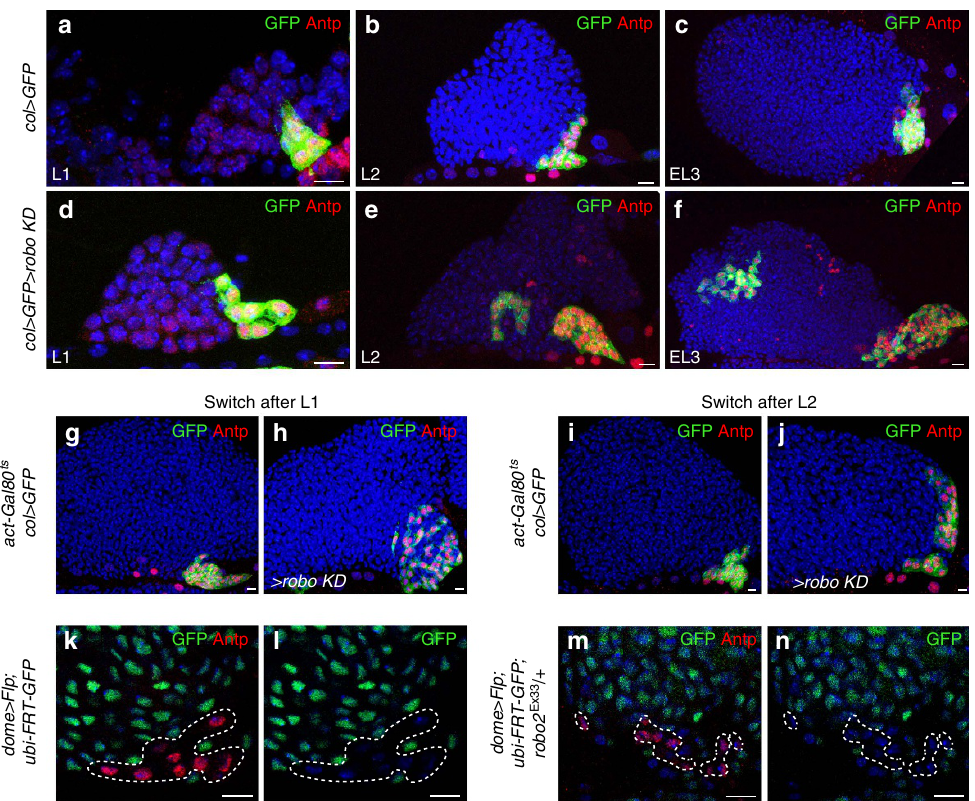
Figure 2 | Robo receptors are required to control PSC morphology during larval development and MZ lineage tracing. ( a – f ) Antp (red) and GFP (green) label PSC cells in control ( col 4 GFP ) ( a – c ) and in col 4 robo KD LGs ( d – f ). ( a , d ) L1 larvae, ( b , e ) L2 larvae and ( c , f ) early L3 larvae. ( g , j ) Antp (red) and GFP (green) label PSC cells in Gal80ts context; control ( col 4 ) ( g , i ) and in col 4 robo KD LGs ( h , j ). The temperature shift (18–29 (cid:2) C) was performed in L1 ( g , h ) or L2 ( i , j ), and LGs were analysed in L3. ( k – n ) Antp (red) labels PSC cells ( k , m ) and GFP (green) labels MZ lineage traced cells in control (dome 4 Flp; ubi 4 FRT 4 GFP) ( k , l ) and in robo2 Ex33 / þ heterozygous mutant (dome 4 Flp; ubi 4 FRT 4 GFP; robo2 Ex33 / þ ) ( m , n ). Nuclei are labelled with 4,6-diamidino-2-phenylindole (blue) ( a – n ). Scale bars, 10 m